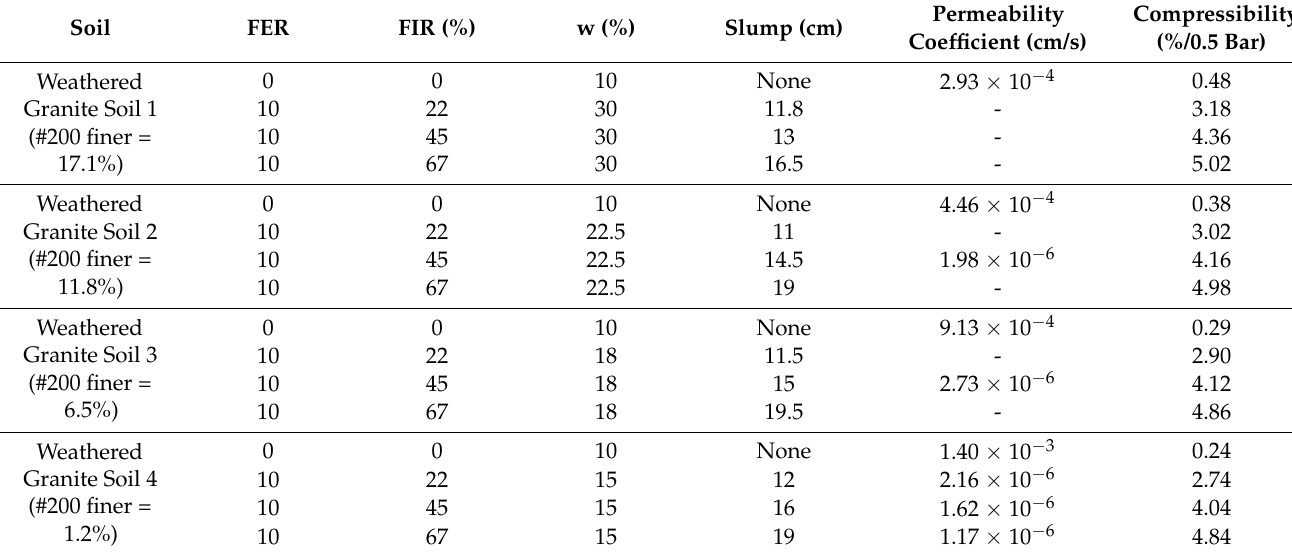
Figure 5. Allowable water contents and upper/lower bounds depending on fine particle contents. Table 3. Properties of conditioned soils depending on foam mix